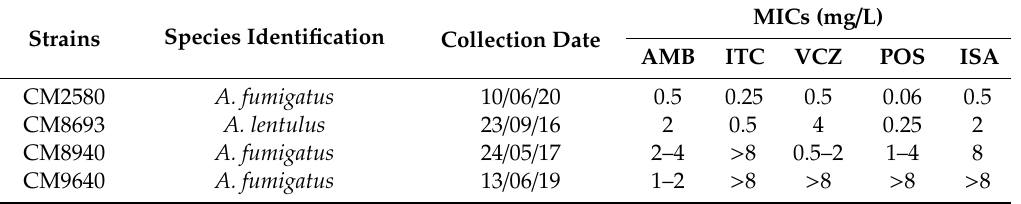
Table 1. Minimal inhibitory concentrations (MICs) for A. fumigatus and A. lentulus isolates against antifungal drugs (AMB: Amphotericin B, ITC: itraconazole, VCZ: voriconazole, POS: posaconazole, ISA: